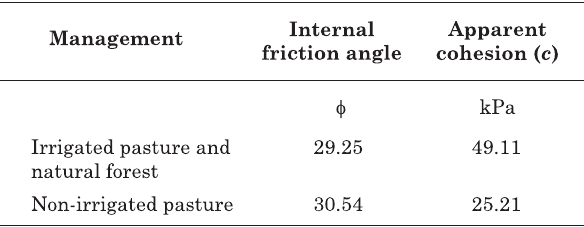
Table 4. Results of the direct shear test with samples equilibrated at a water tension of 6 kPa